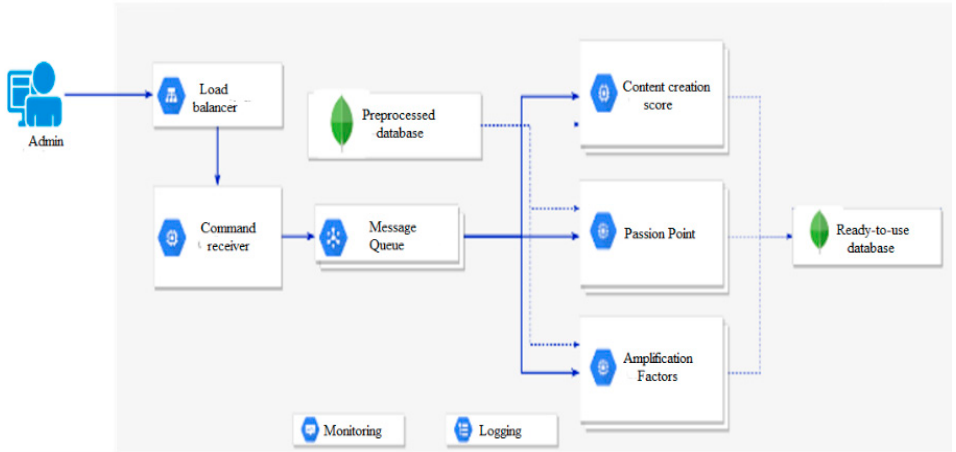
Figure 5. Determination of influential measures of users.